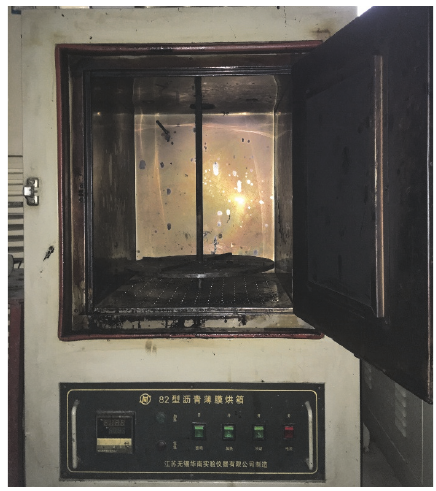
Figure 4: TFOT oven.